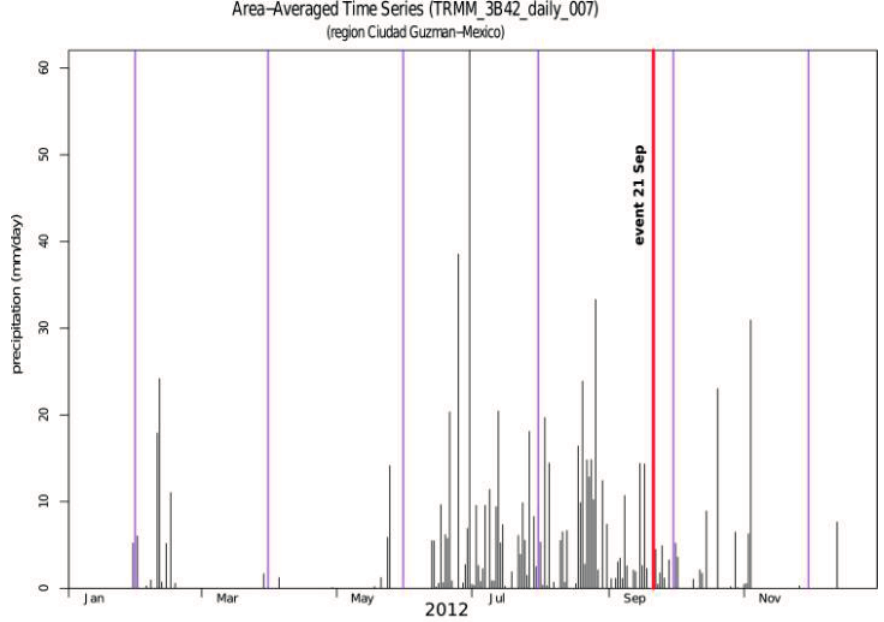
Figure 10. Rainfall estimates from TRMM (Tropical Rainfall Measuring Mission—NASA) 3B42 Daily ver.007 data for